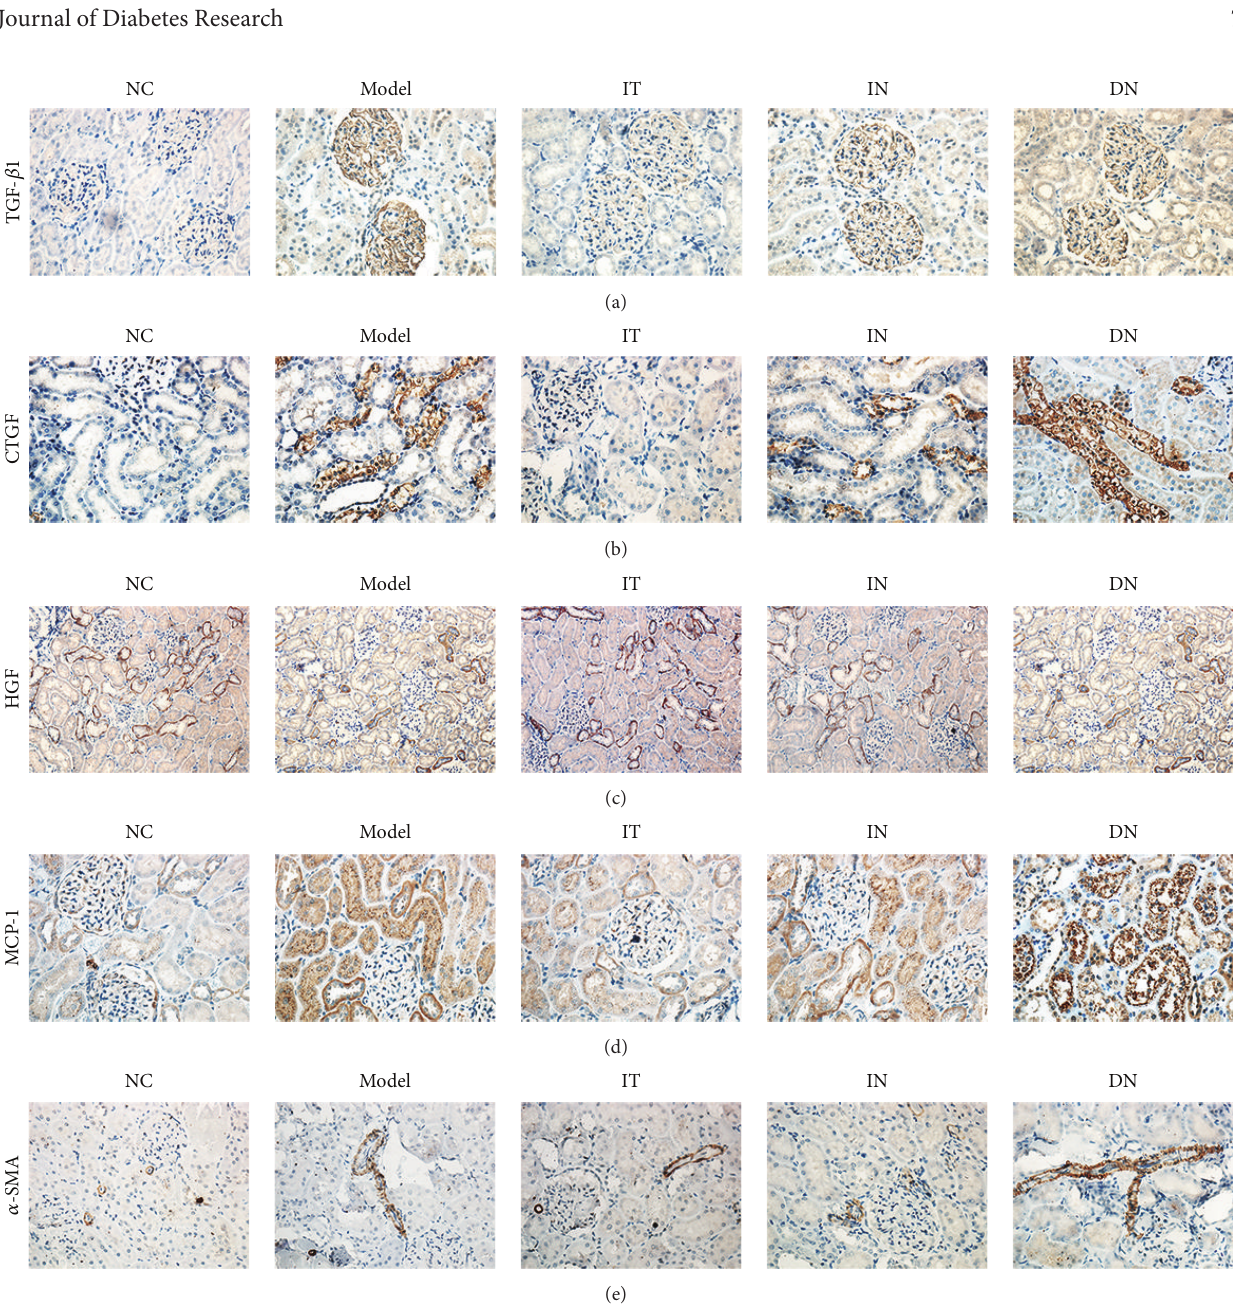
Figure 4: Immunohistochemical staining of renal fibrogenic and interstitial fibrosis factors in each group. (a) TGF- 𝛽 1. (b) CTGF. (c) HGF. (d) MCP-1. (e) 𝛼 -SMA. Model group: diabetic nephropathy model rats established at 12